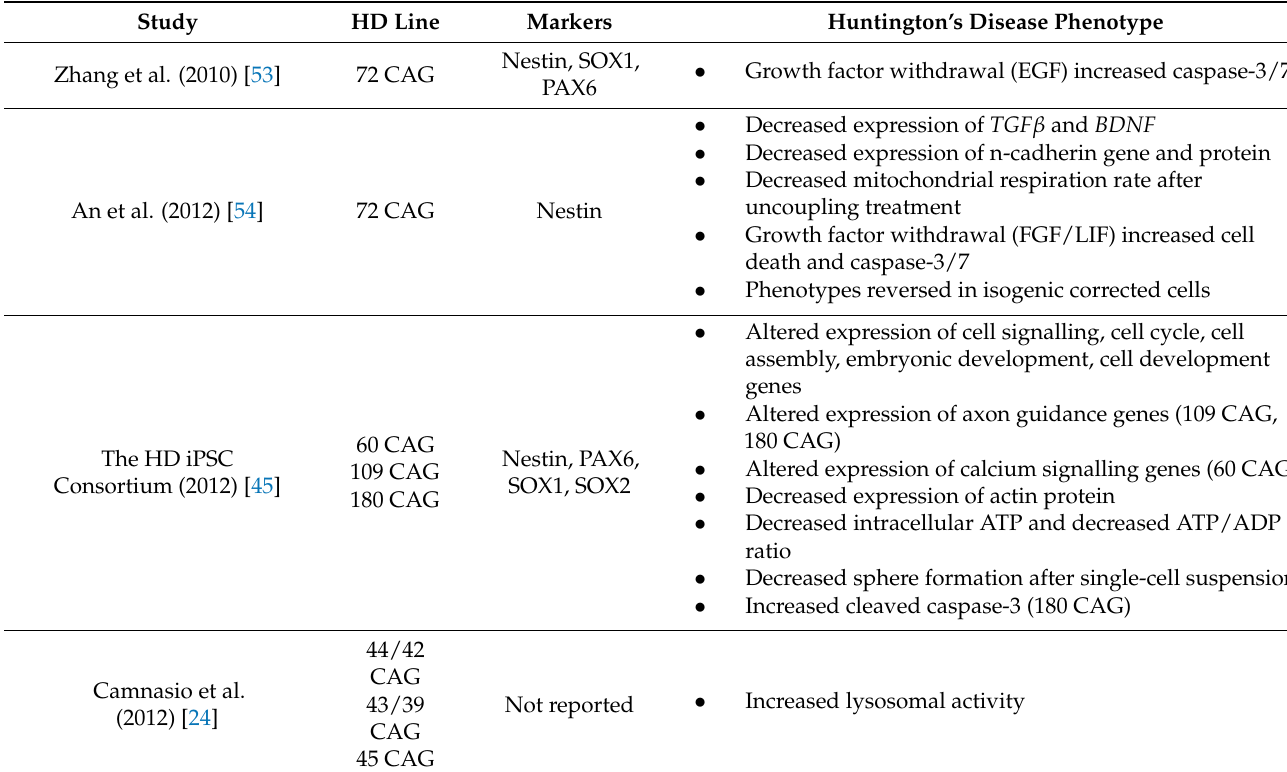
Table 4. Phenotypes observed in Huntington’s disease neural precursor cells derived from induced pluripotent stem cells.